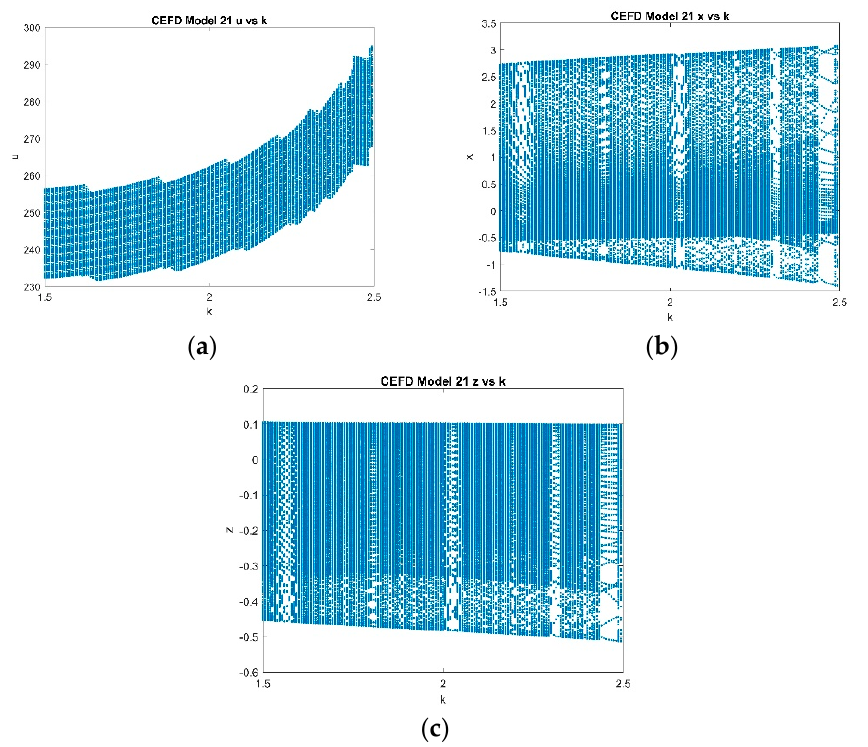
Figure 18. CEFD model (21); ( a ) u vs. k , ( b ) x vs. k , ( c ) z vs. k , at p = 1, α 5 = 0.3, k ∈ [ 1.5, 2.5 ] .